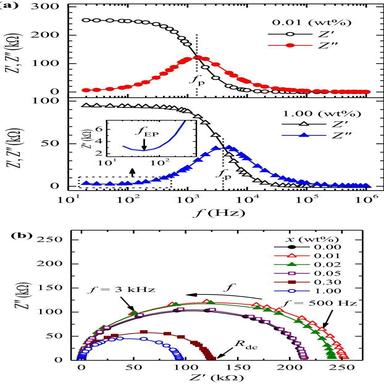
(a) Complex impedance (Z0 and Z00) spectra of GLY/x (wt%) ZnO nanofluids for x = 0.01 and 1.00, and the inset shows the enlarged view of Z00 spectrum for 1.00 wt% ZnO in the frequency range from 10 Hz to 500 Hz, and (b) Debye type complex plane plots (Z00 versus Z0 ) for the GLY/x (wt%) ZnO nanofluids (x = 0.00, 0.01, 0.02, 0.05, 0.30, and 1.00), at 25 C.